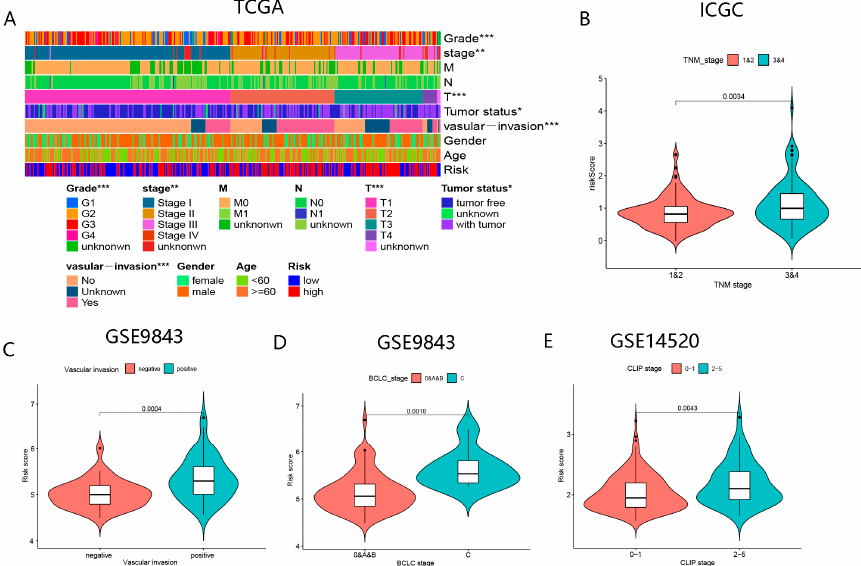
Figure 8. The correlation of risk scores with clinical indicators in diverse cohorts. ( A ) The correlation of risk scores and TMN-stage, vascular invasion, tumor status, and grade in TCGA-LIHC. ( B ) Com- parison of risk scores between diverse TNM-stage in ICGC-JP. ( C ) Comparison of risk scores be- tween positive and negative vascular invasion in GSE9843. ( D ) Comparison of risk scores between